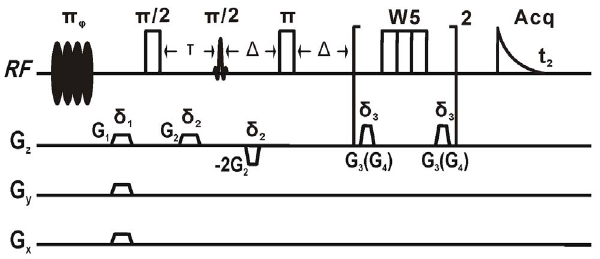
Figure 1. Hadamard-encoded iMQC pulse sequence.